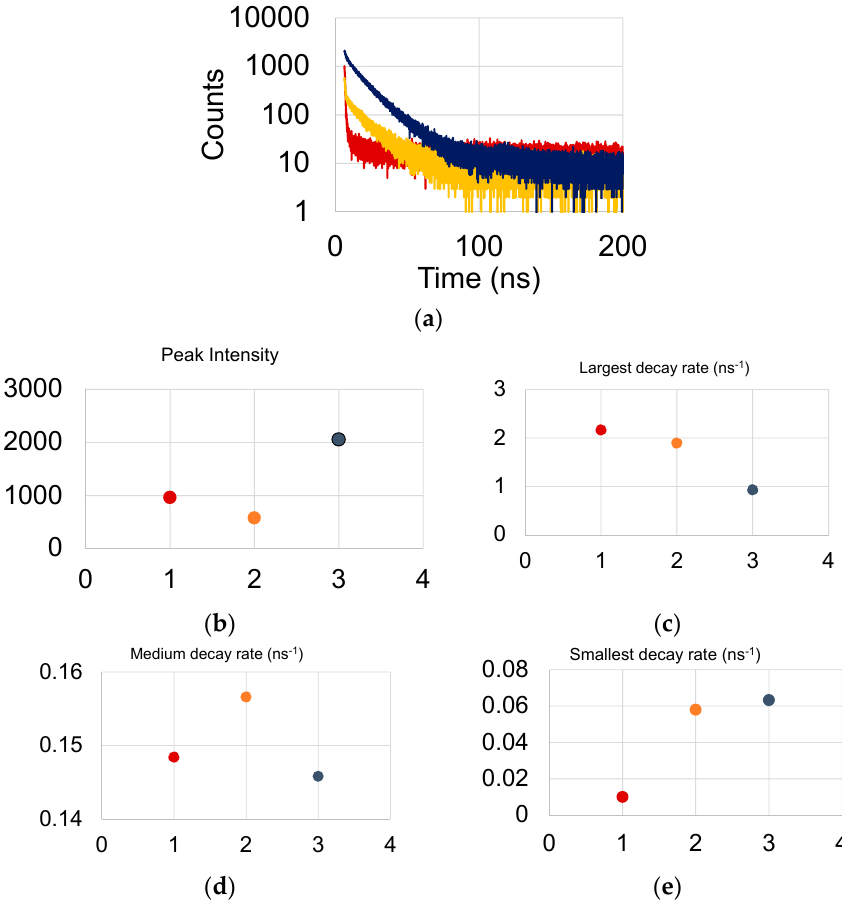
Figure 3. ( a ) Red to blue: as the focus of the laser beam is receding away from the sample surface, ( b ) the peak intensity changes, ( c ) the larger decay rate becomes smaller, ( d ) the medium decay rate remains fairly constant and ( e ) the smallest decay rate increases.